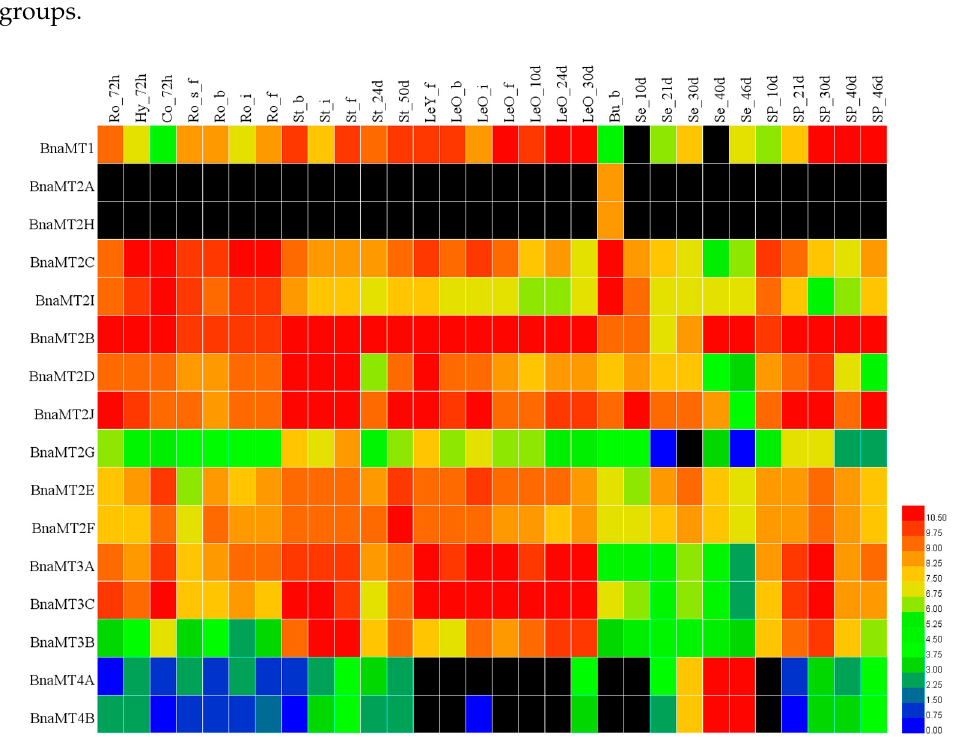
Figure 6. Heatmap of the expression profiles of BnaMT family genes in different tissues and organs. The abbreviations above the heatmap indicate the different tissues and organs/developmental stages of B . napus ZS11 (listed in Table S1). The expression data was gained from the RNA-seq data and shown as log2, as calculated by fragments per kilo base of exon model permillion (FPKM) values. Black boxes indicate that no expression was detected by RNA-seq analysis. The heatmap was generated using Heatmap Illustrator v1.0 (HemI v1.0, Huazhong University, Wuhan, China; http://hemi.biocuckoo.org/contact.php).